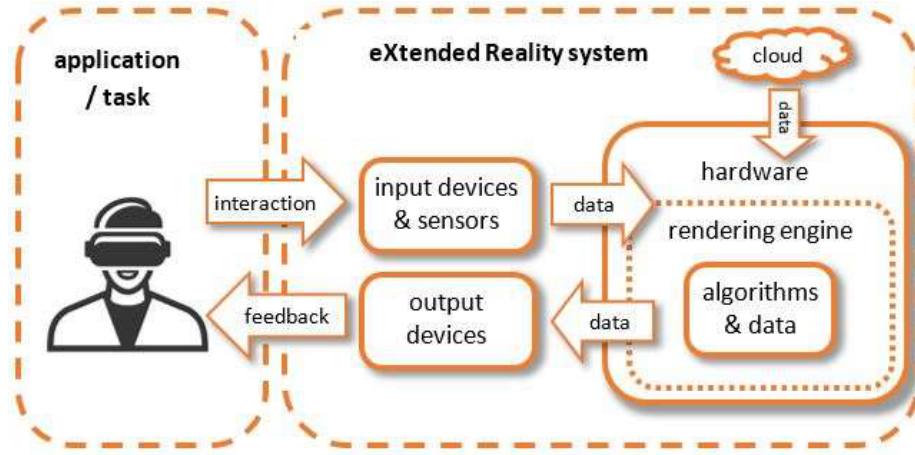
Figure 2. Major Components of an Extended Reality System [24].